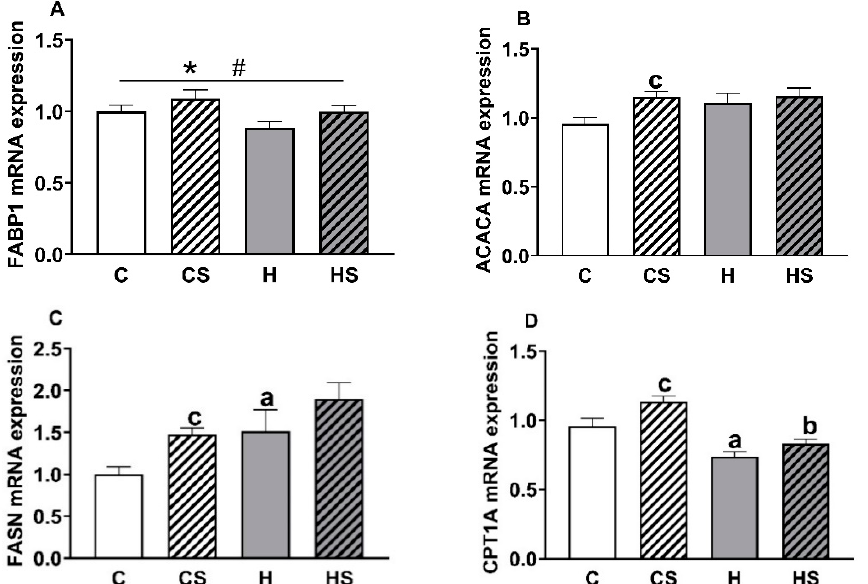
Figure 6. Expression of liver genes involved in lipid metabolism. Data are shown as mean ± SEM ( n = 14–16 per group); panels A, B, C and D show mRNA expression of FABP1, ACACA, FASN and CPT1A genes respectively. Abbreviations: C, Control diet; CS, Control diet with supplement; H, HFD; and HS, HFD with supplement. Effects of HFD and supplement were assessed by two-way ANOVA followed by LSD post hoc. Post hoc HFD effect ‘a’ (H versus C) and ‘b’ (HS versus CS), and supplement effect ‘c’ (CS versus C). Overall HFD effect * p < 0.05, p < 0.01 or p < 0.001. Overall supplement effect # p < 0.05 or p < 0.01.